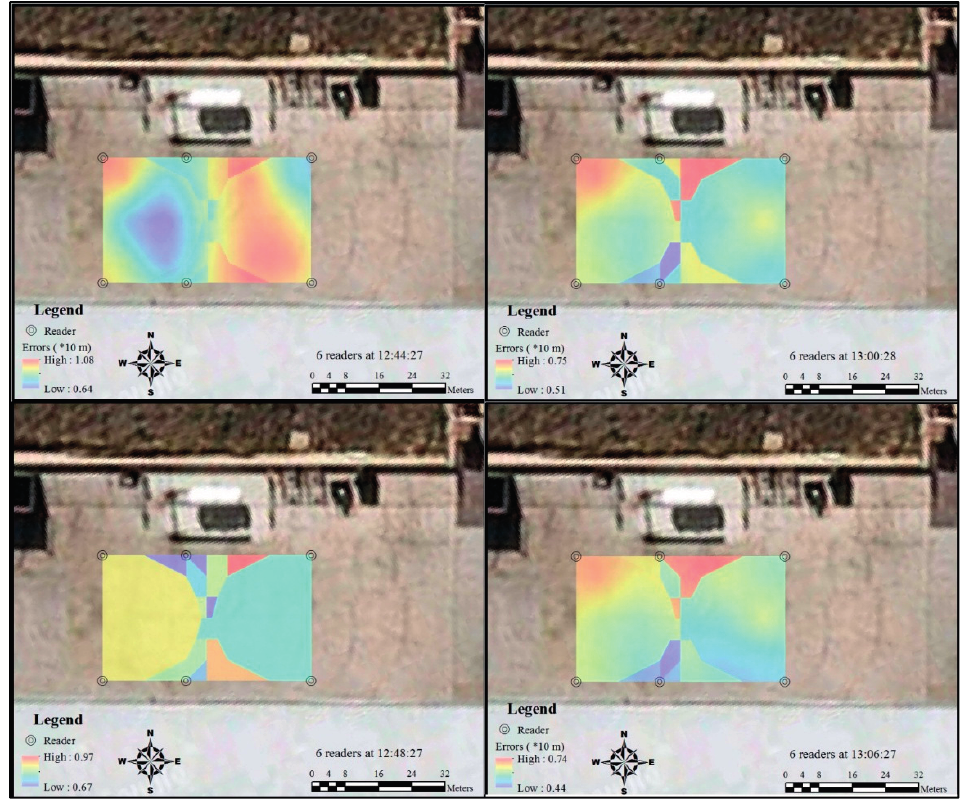
Figure 9. Spatial and temporal variation of RFID errors distribution by six